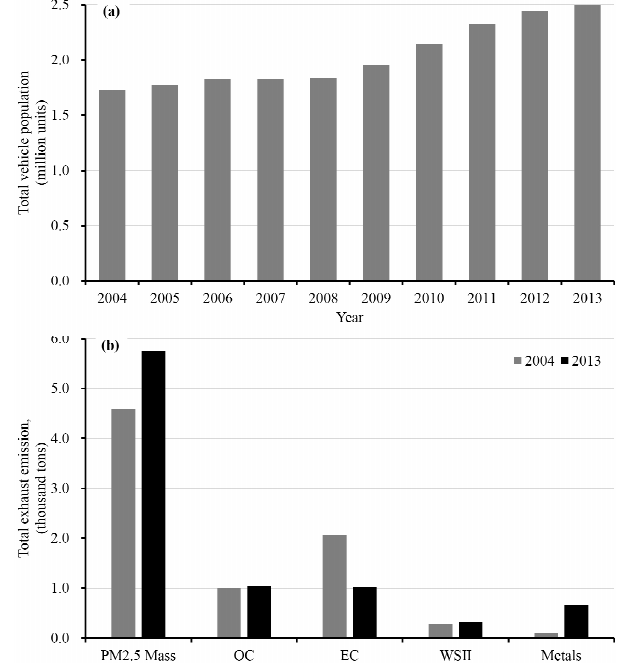
Figure 5. (a) Growth in total vehicle population in Guangzhou dur- ing 2004–2013. (b) Total exhaust emissions of PM 2 . 5 mass, OC, EC, WSII and metal in 2004 and